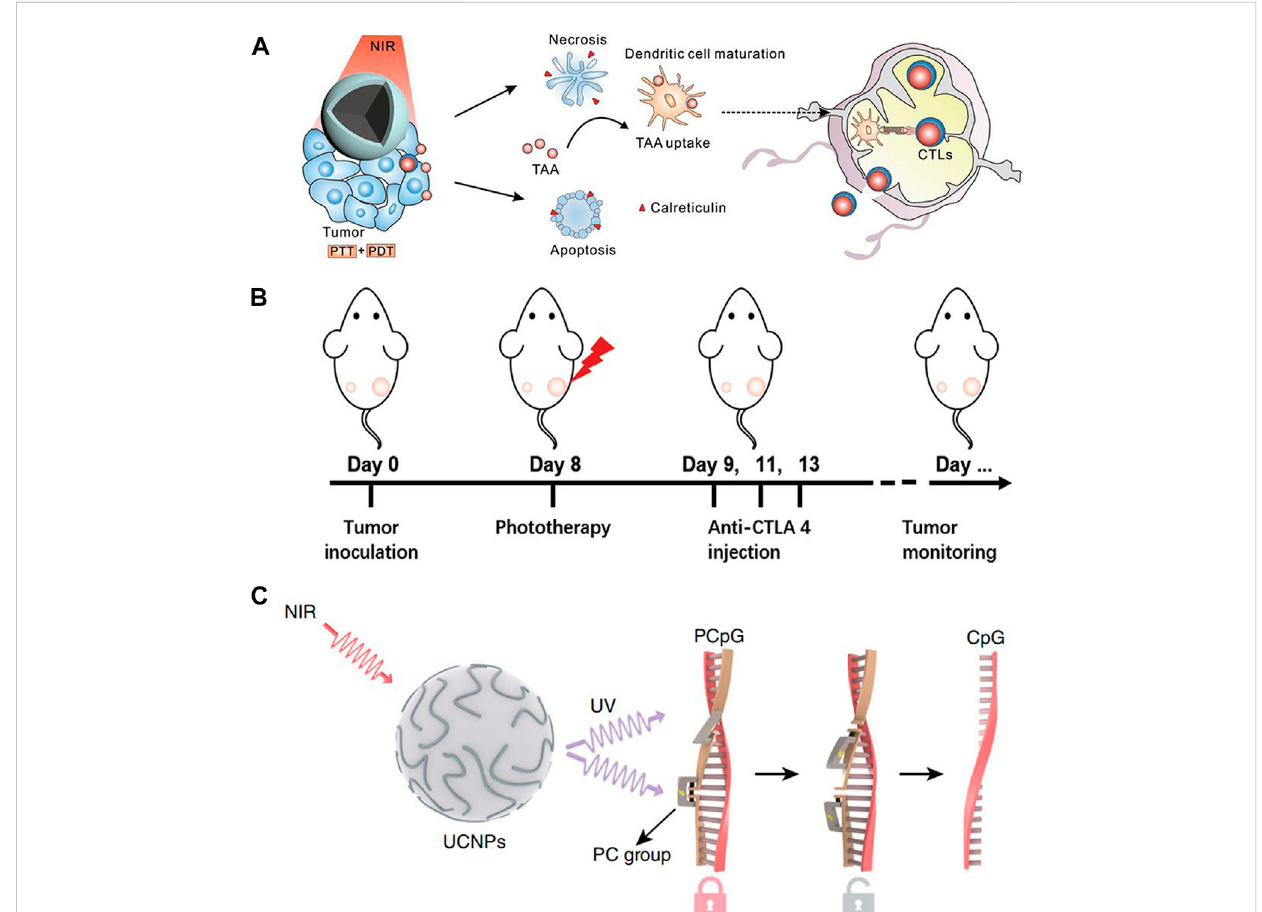
FIGURE 7 (A) Scheme of synergistic phototherapy for augmentation of antitumor immunity. Upon laser irradiation, nanoparticles ablate the primary tumor through phototherapy. (Reprinted with permission from Ref. (Yan et al., 2019) Copyright 2019: John Wiley & Sons, Inc.). (B) Schematic depiction of the experimental approach for the evaluation of the abscopal effects induced by Ln-UCNPs/ICG/RB-mal based phototherapy. (Reprinted with permission from Ref. (Wang et al., 2019a) Copyright 2019: John Wiley & Sons, Inc.). (C) Schematic of the design of a photoactivatable immunodevice through